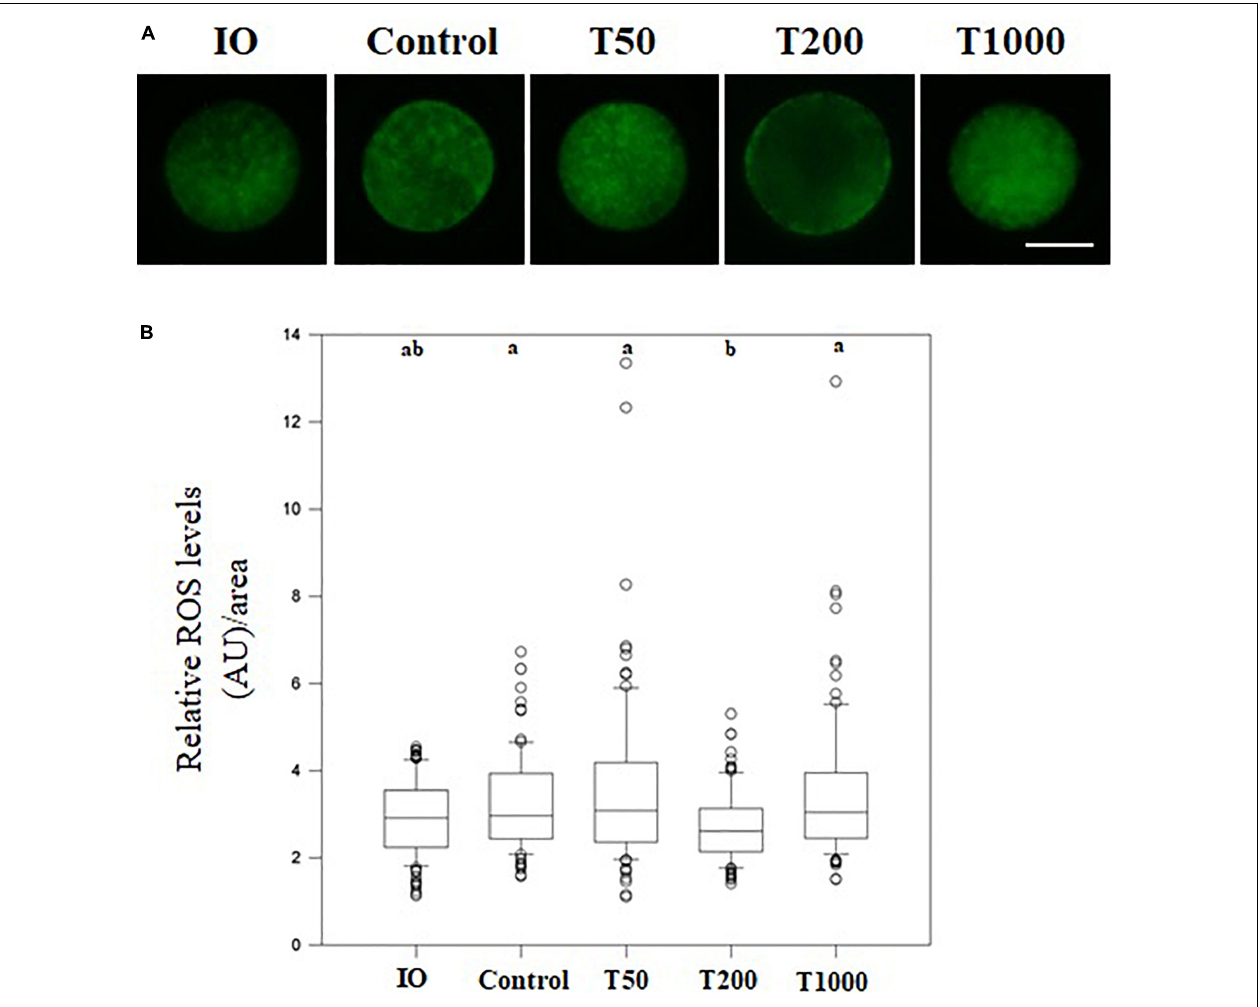
FIGURE 3 | Intracellular ROS levels in oocytes matured in vitro in the presence of increasing TUDCA concentrations. (A) Representative photomicrographs of bovine oocytes stained with Cell Rox Green for ROS semi-quantitative quantification. Bar = 50 µ m. (B) Results are presented as the median and first and third interquartile interval of five replicates using 87–95 COCs/treatment. Different letters in each box represent significant differences ( P ≤ 0.06). IO, immature oocyte; Control, 0 µ M TUDCA; T50, 50 µ M TUDCA; T200, 200 µ M TUDCA; T1000, 1,000 µ M